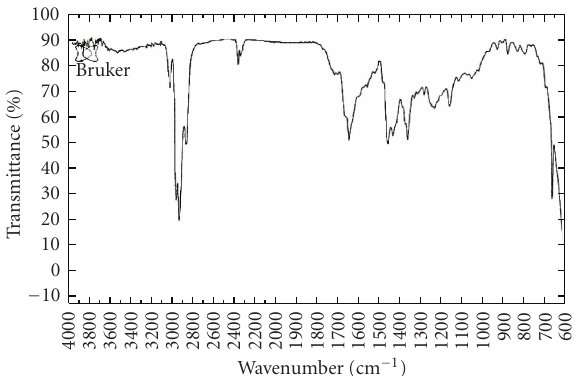
Figure 4: FT-IR spectrum of poly[(3-(6-(9-anthracenyloxy)hexyl) thiophene)-co-(3-(6-bromohexyl)thiophene)] (V).